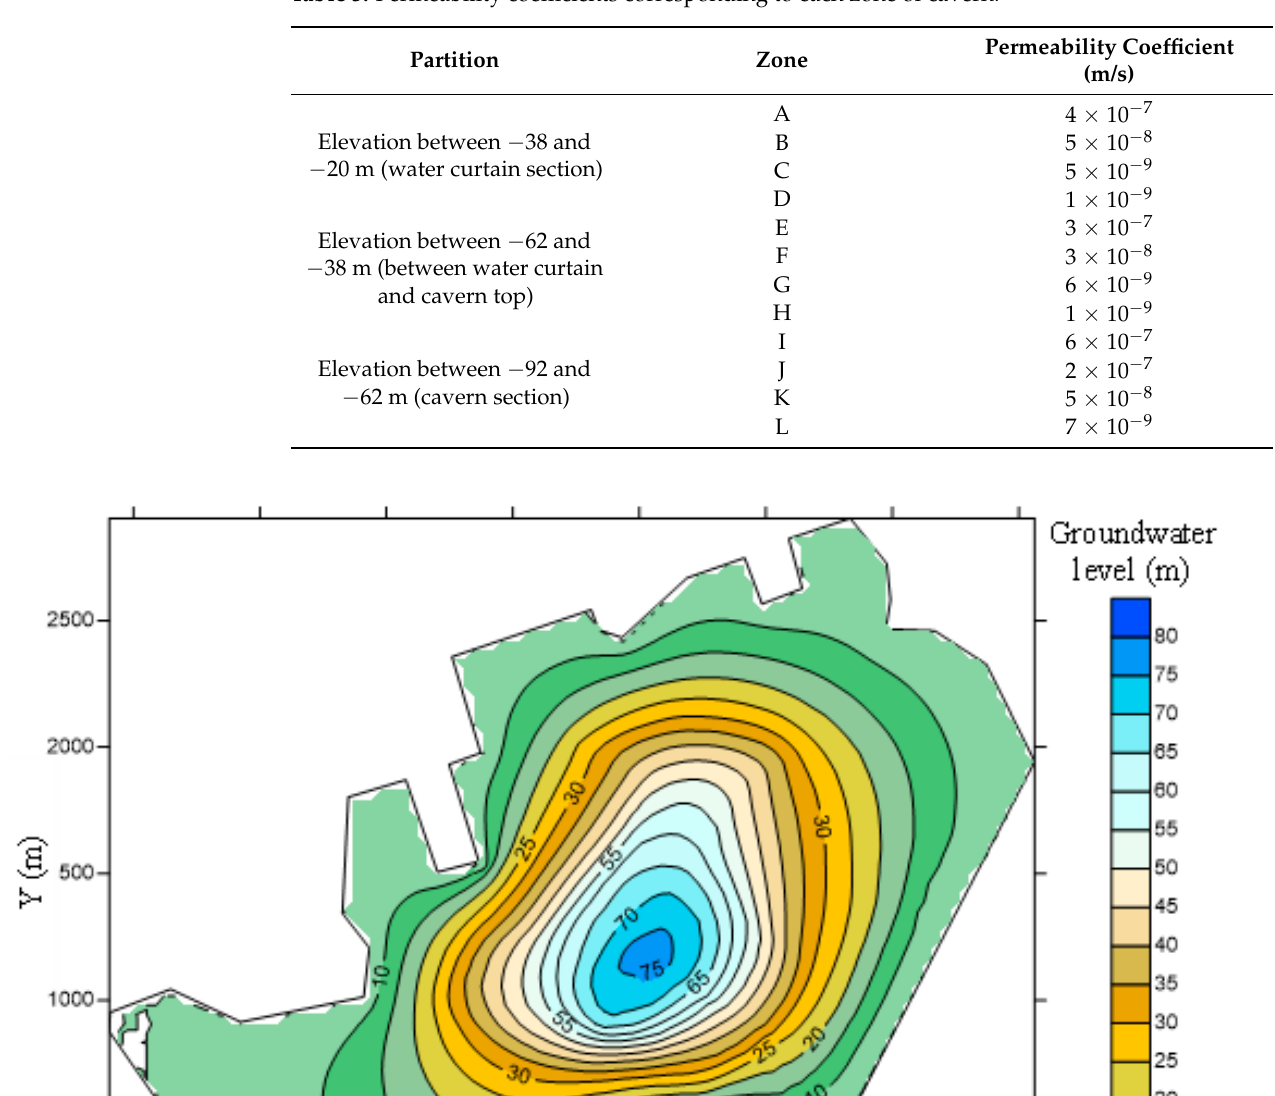
Table 3. Permeability coefficients corresponding to each zone of cavern.